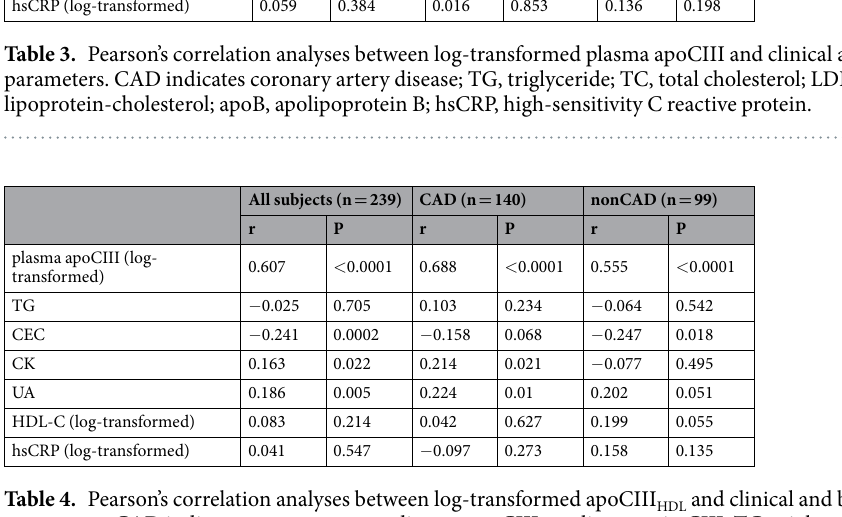
Table 4. Pearson’s correlation analyses between log-transformed apoCIII HDL and clinical and biochemical parameters. CAD indicates coronary artery disease; apoCIII, apolipoprotein CIII; TG, triglyceride; CEC,